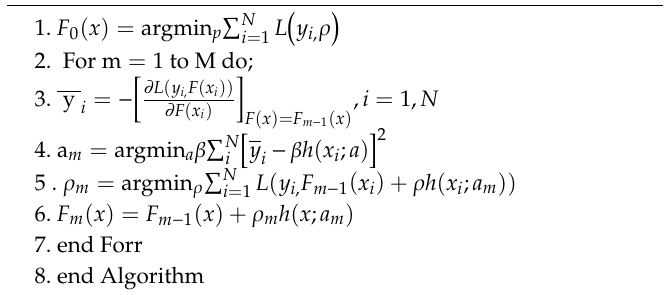
Algorithm 1. Gradient Boosting Regression Tree (GBRT).